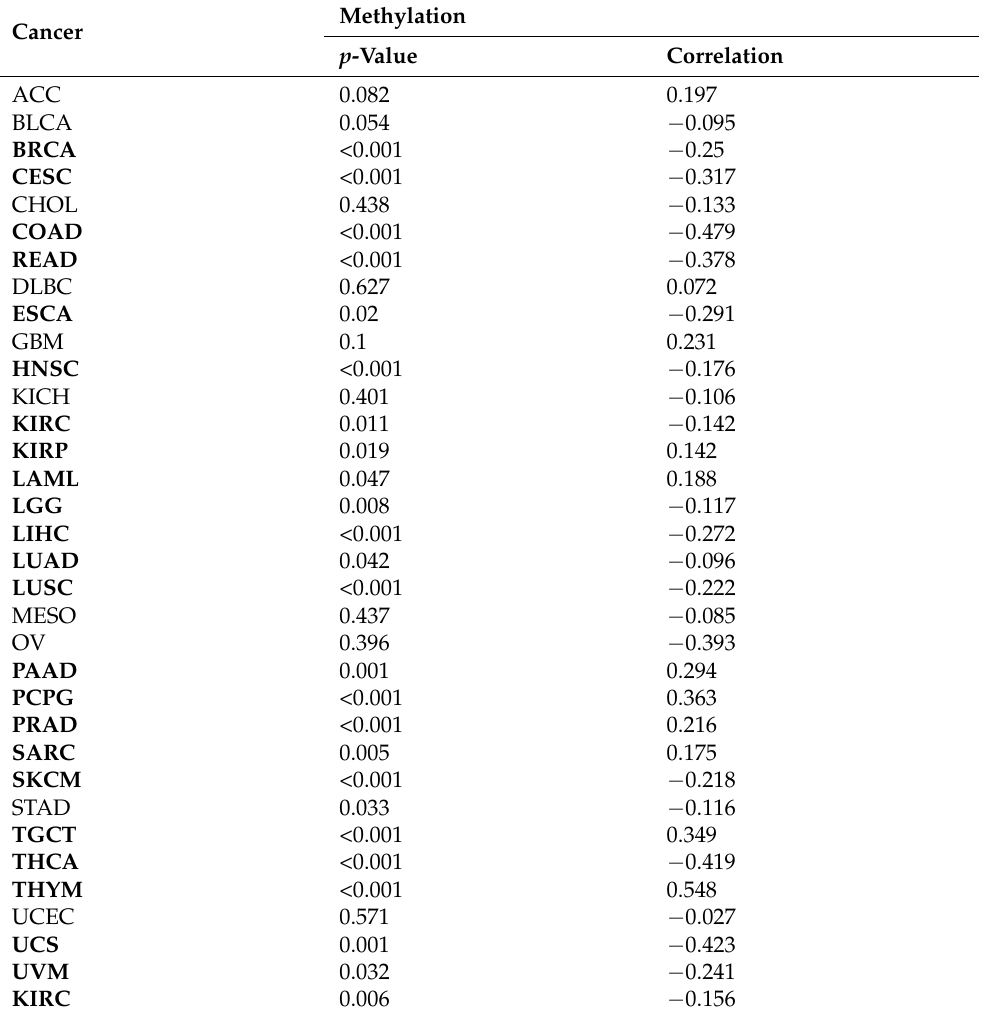
Table 1. Association of STK38 expression with DNA methylation. Cancer